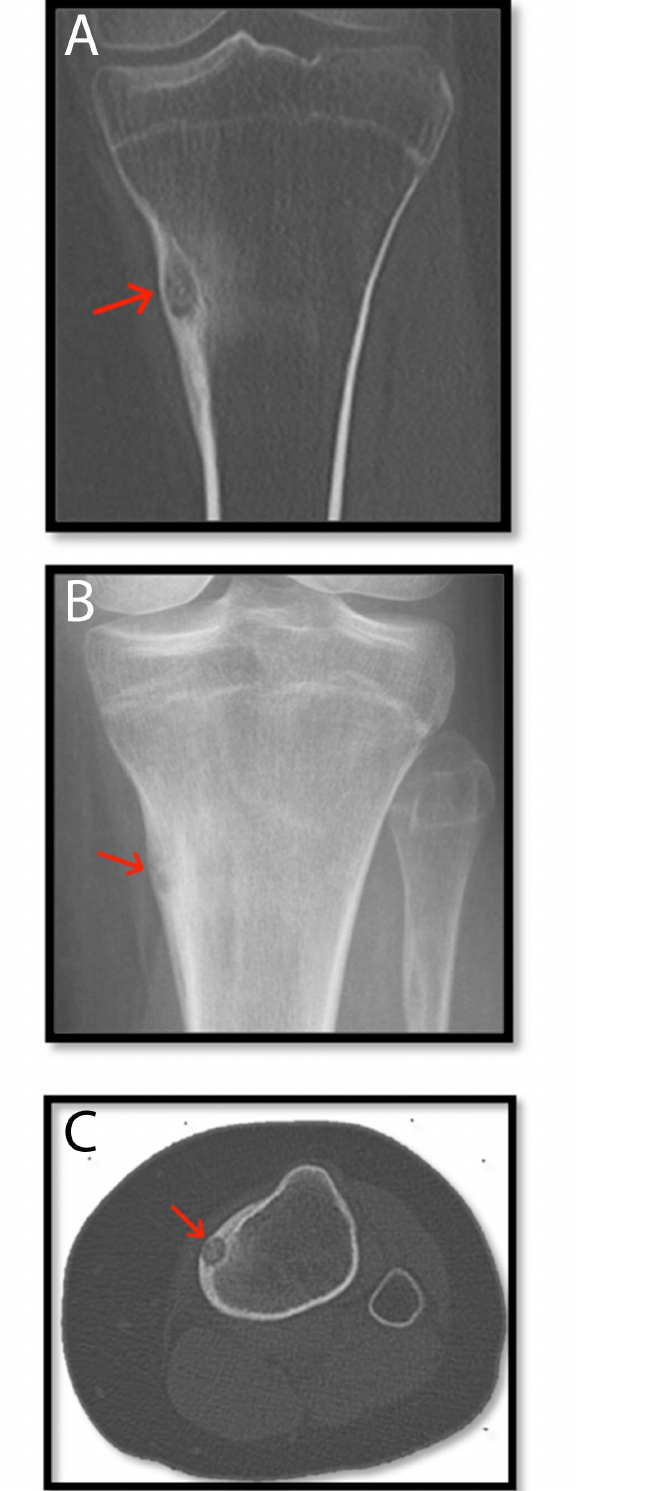
Fig 2. A-C. Osteoid osteoma in